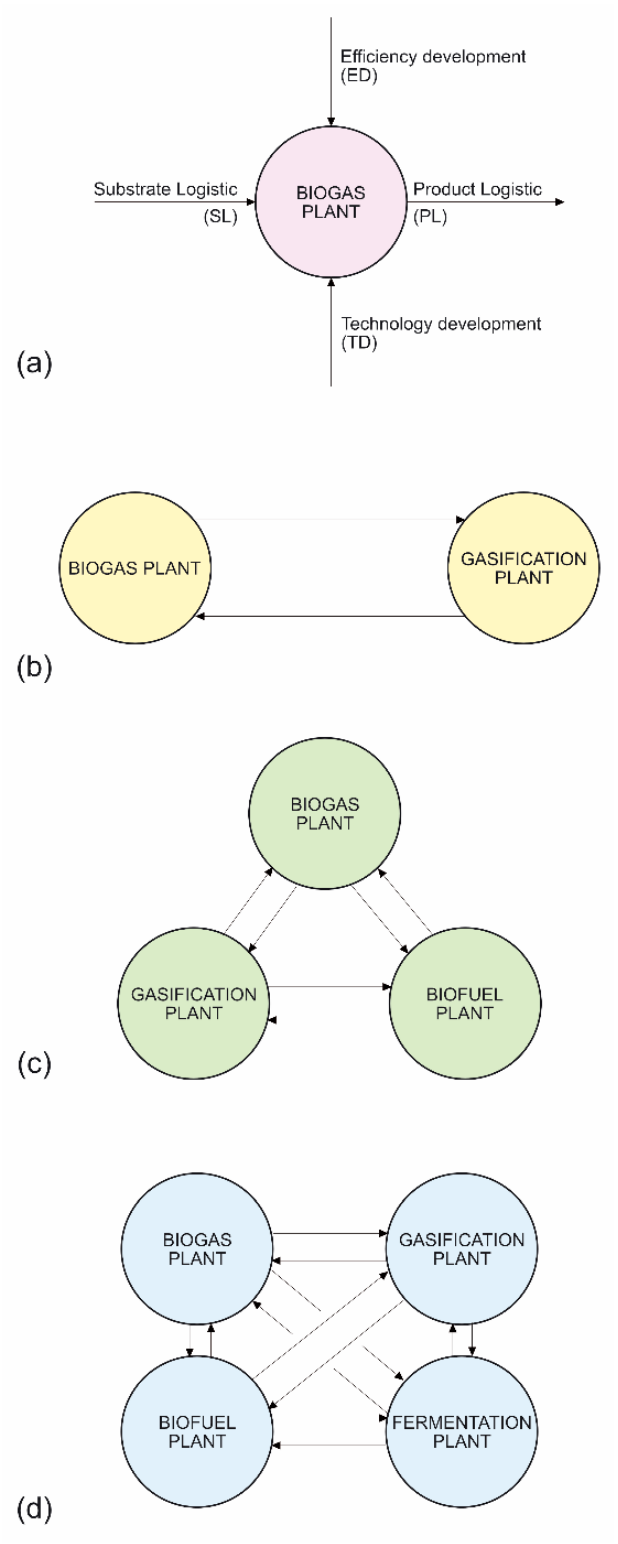
Figure 9. Biomass refinery systems: ( a ) single-, ( b ) two-, ( c ) three-, and ( d ) four-module configurations. The arrows between modules indicate possible technological links between them.